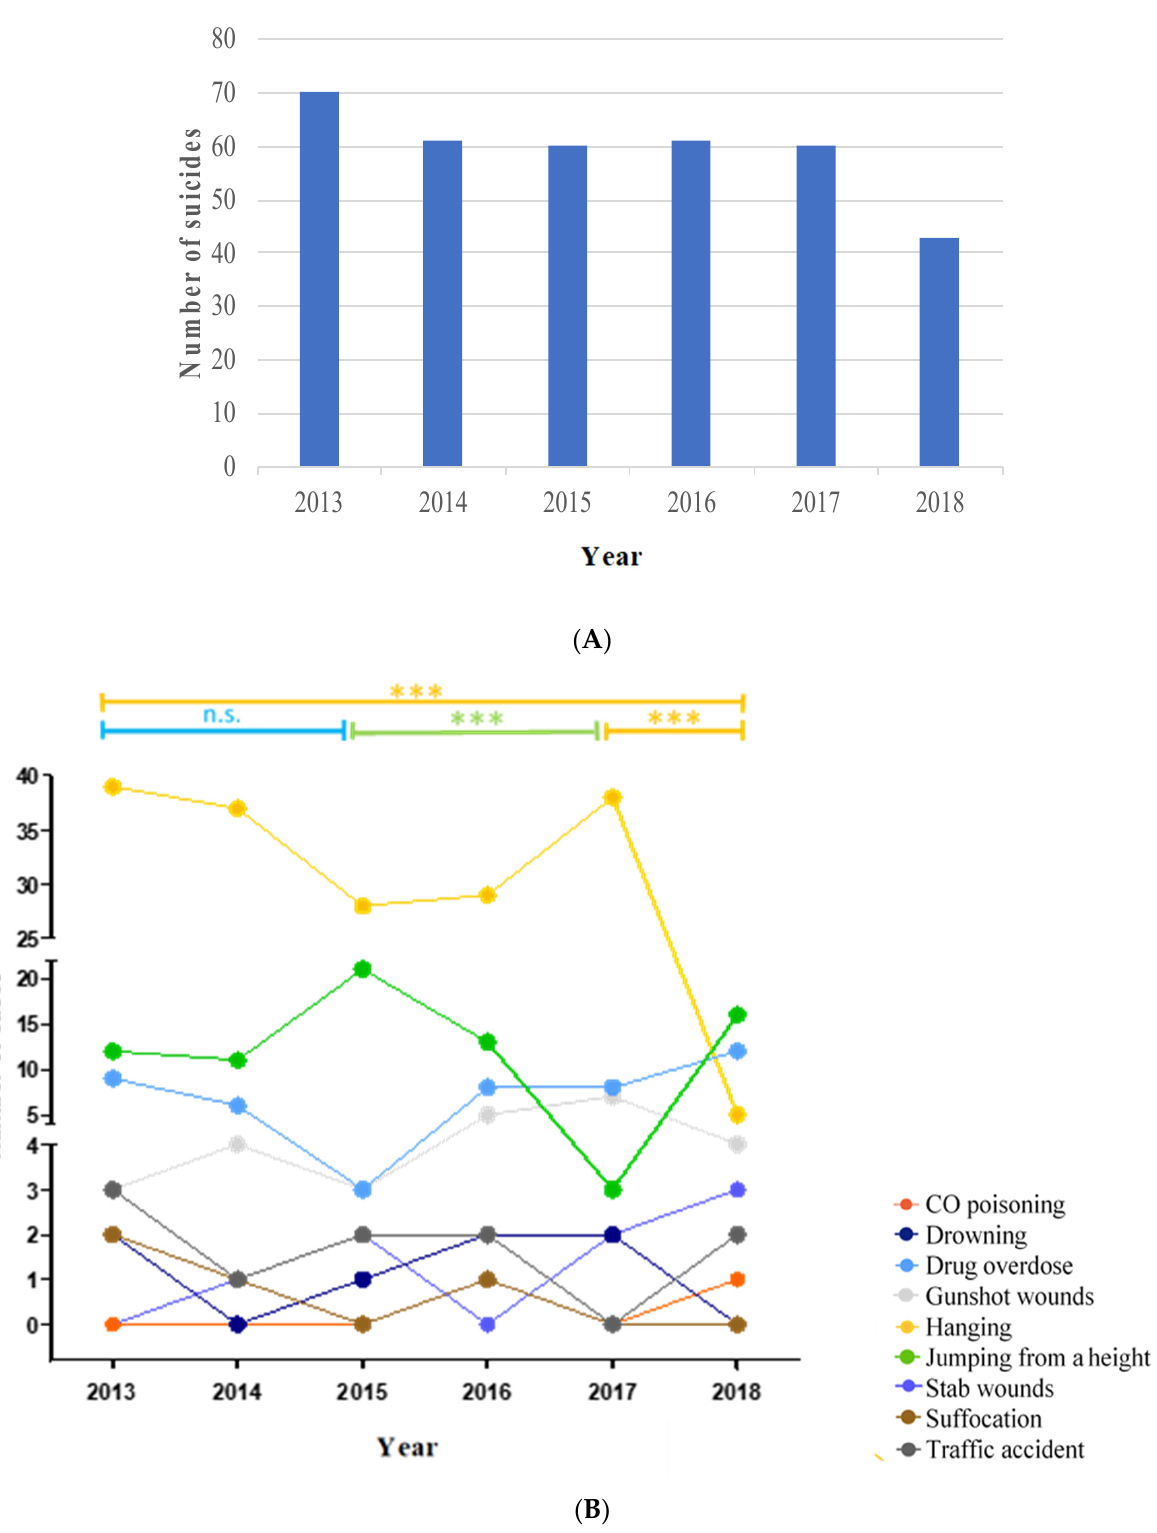
Figure 3. Analysis of the suicides analyzed in the time period of this study. ( A ) Number of suicides that occurred in the analyzed study period. ( B ) Classification of the number of suicides and the suicide mechanism analyzed. n.s: not statistically significant. *** p < 0.001.